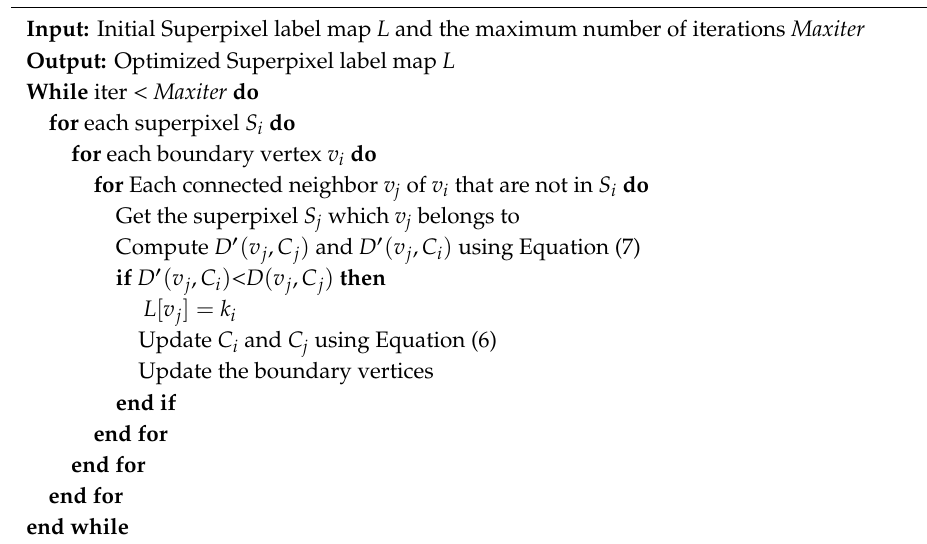
Algorithm 3. Boundary